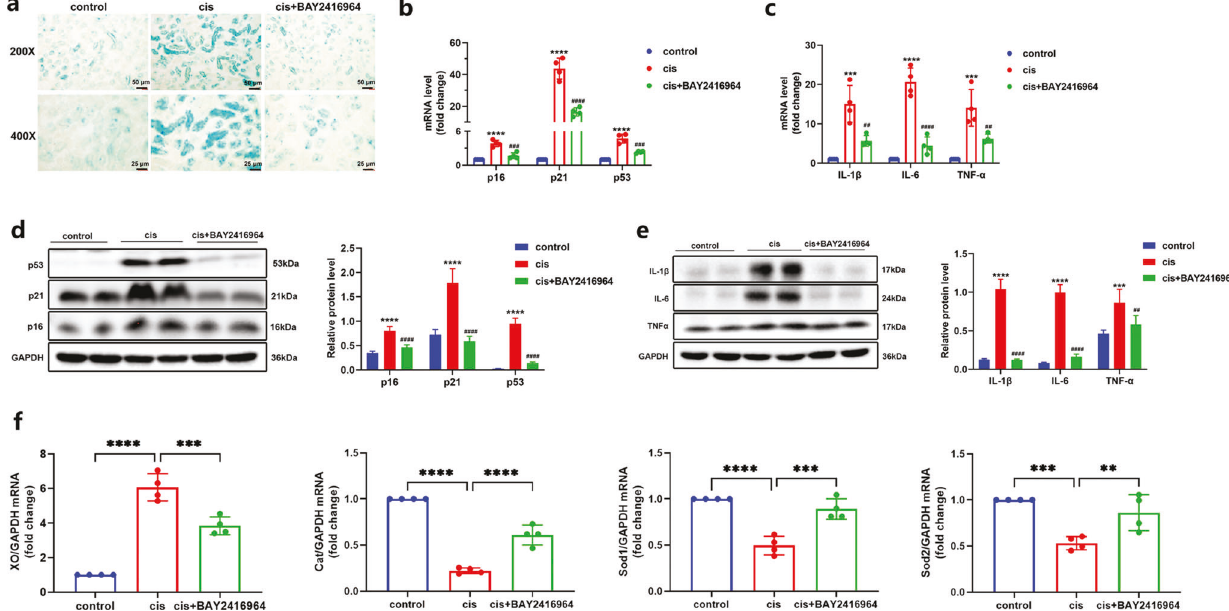
Fig. 3 AhR inhibition by BAY2416964 suppressed senescence phenotype and oxidative stress in kidneys of cisplatin-induced mice. a Representative senescence photographs of SA- β -Gal staining in cisplatin-induced kidneys (magni fi cation ×200 and ×400); Blue: SA- β -gal positive region. b The mRNA levels of p16, p21, and p53 in different groups of mice ( n = 4). c The mRNA levels of IL-1 β , IL-6 and TNF α ( n = 4). d Protein expression of p16, p21 and p53 were quanti fi ed by densitometry and normalized with GAPDH. e Protein expression of IL-1 β , IL-6, and TNF α were quanti fi ed by densitometry and normalized with GAPDH; **** P < 0.0001, *** P < 0.001 compared with the control group; #### P < 0.0001, ### P < 0.001, ## P < 0.01 compared with cisplatin group. All western blot analysis was performed in two randomized mice from each group, and the experiments were repeated in triplicate. f The mRNA expression of XO, Cat, Sod1, and Sod2 ( n = 4); Data are represented as means ± SDs. cis, cisplatin. **** P < 0.0001, *** P < 0.001, ** p <